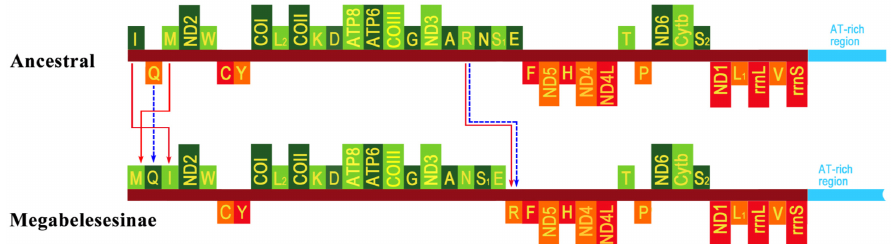
Figure 1. Mitochondrial genome organization of Megabelesesinae with reference to the ancestral type of insect mitochondrial genomes. Genes transcribed from the J- and N-strands are shown in green and orange, respectively. The A + T-rich region is indicated by blue, and tRNA genes are labeled by their single-letter amino acid code.